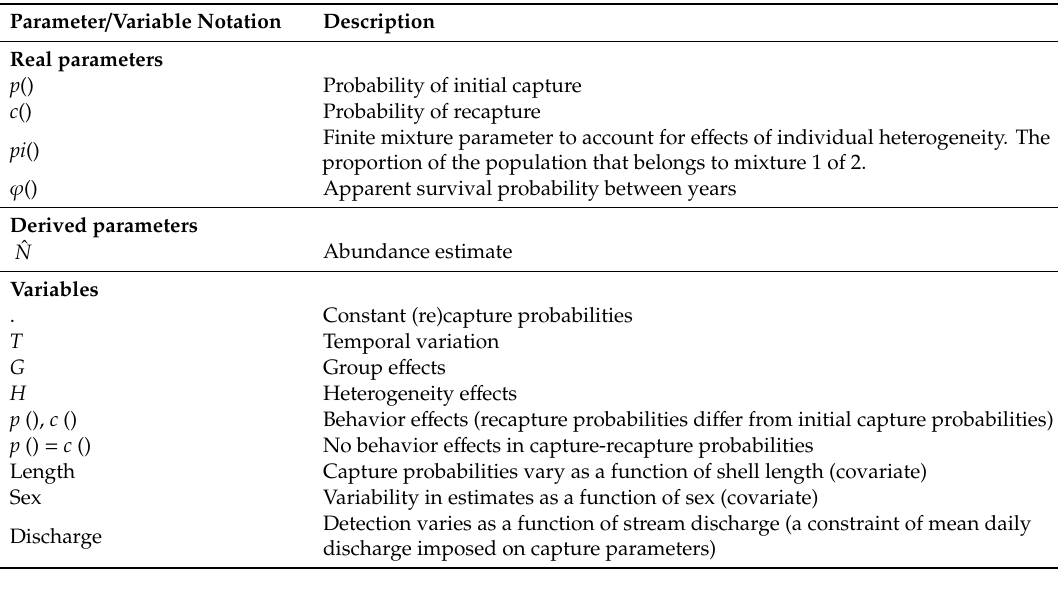
Table 1. Definitions for real and derived parameters, and variables used in 2011 and 2012 Epioblasma capsaeformis , Actinonaias pectorosa , and Medionidus conradicus Huggins Closed-Capture models (and E. capsaeformis Cormack–Jolly–Seber models) in Program